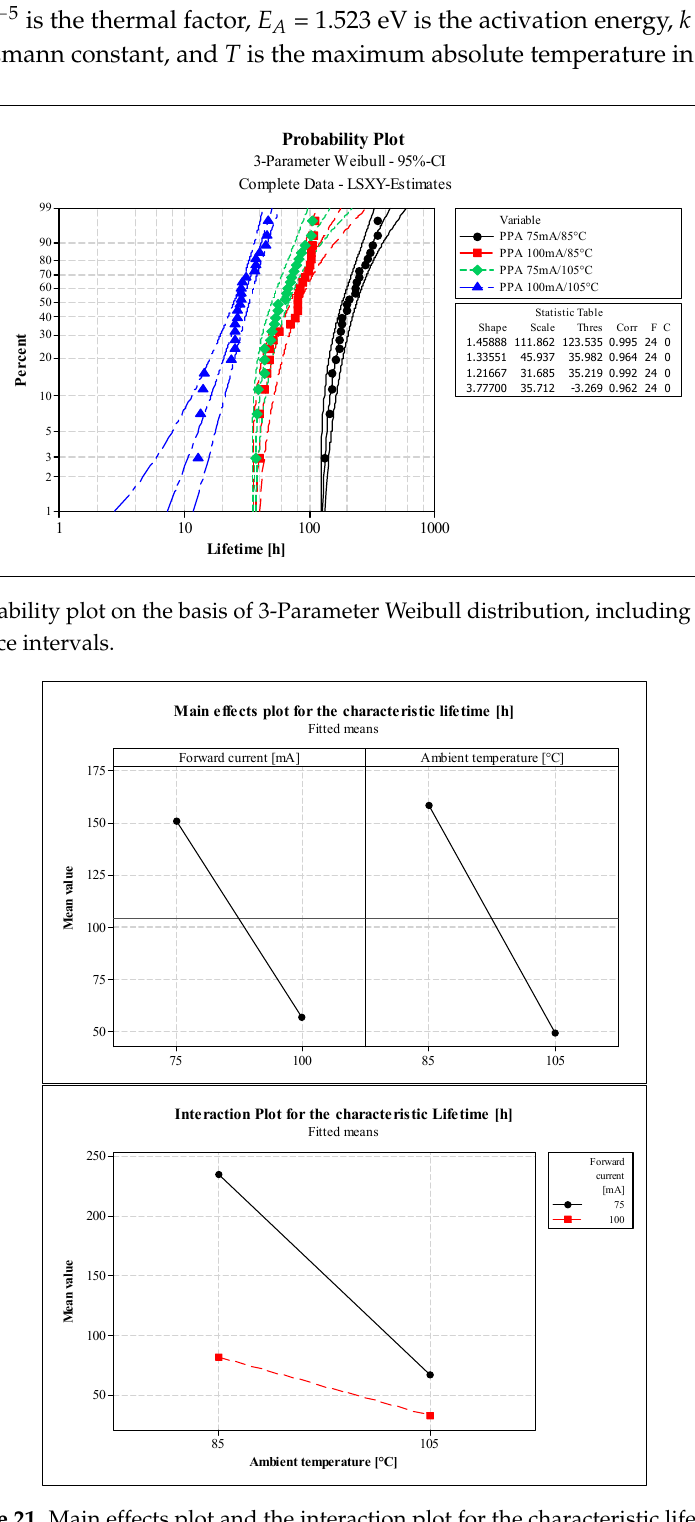
Figure 21. Main effects plot and the interaction plot for the characteristic lifetime.